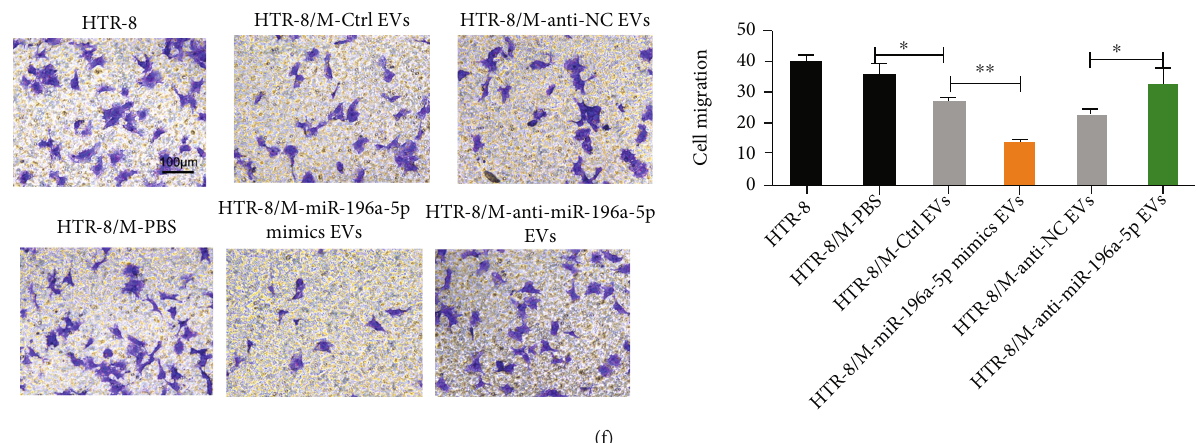
Figure 6: Trophoblast-derived EV miR-196a-5p induces M1 polarization of macrophages to suppress proliferation and invasion and promote apoptosis of HTR-8 cells. (a – c) PMA-pretreated THP-1 cells (M) were transfected with miR-196a-5p mimics and cocultured with HTR-8 cells. (a) CCK-8, (b) fl ow cytometry, and (c) Transwell assays were performed to analyze the proliferation, apoptosis, and migration of HTR-8 cells. (d – f) PMA-pretreated THP-1 cells were treated with EVs derived from miR-196a-5p overexpressing or miR- 196a-5p knockdown HTR-8 cells and further cocultured with HTR-8 cells. (d) CCK-8, (e) fl ow cytometry, and (f) Transwell assays were performed to analyze the proliferation, apoptosis, and migration of HTR-8 cells ( ∗ p < 0 : 05 ; ∗∗ p < 0 : 01 ; ∗∗∗ p < 0 : 001 ). Scale bar of Transwell assays were 100 μ m. EV: extracellular